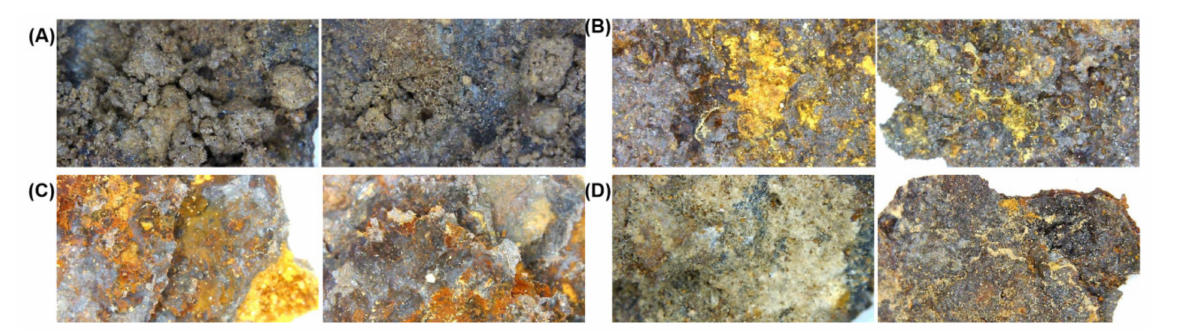
Figure 5. Iron anchor photomicrograph. ( A – D ) are four sample micrographs.